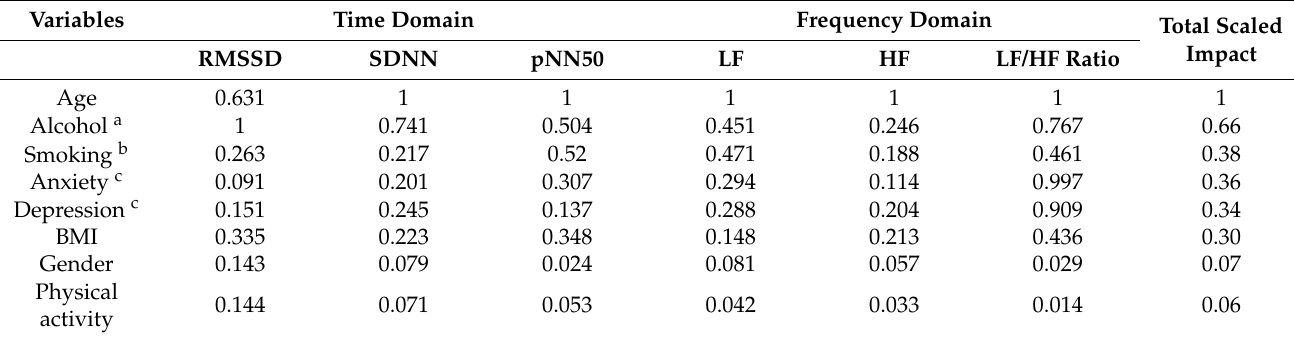
Table 6. Gradient boosting machine learner regression ( n =